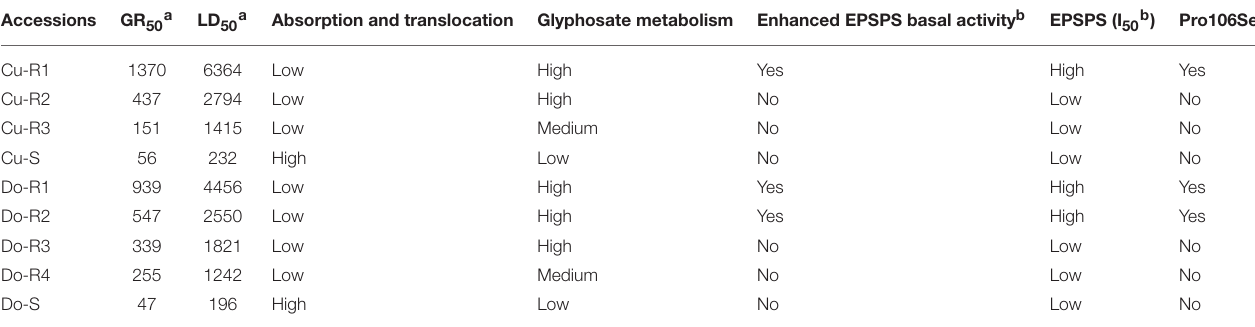
TABLE 6 | Summary of glyphosate resistance mechanisms accumulated by P. hysterophorus accessions studied in this